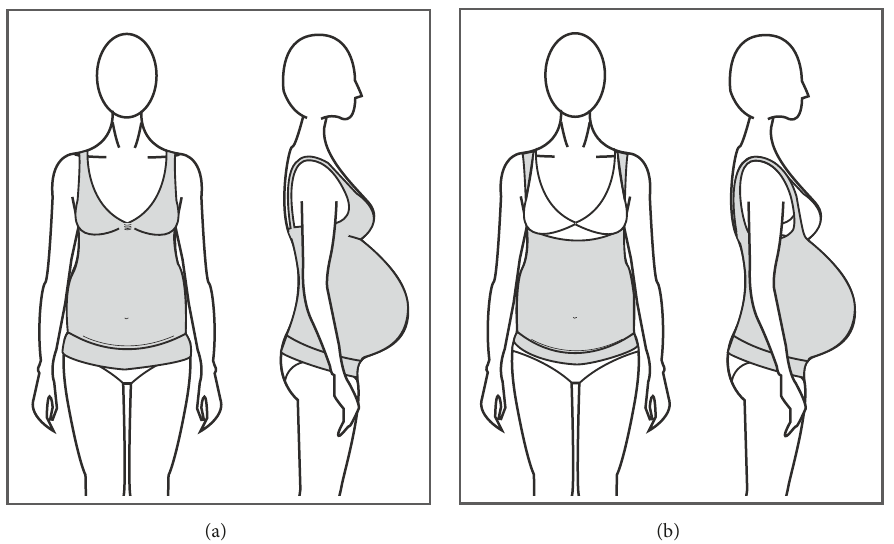
Figure 8: (a) Garment with breast support. (b) Garment without breast support.